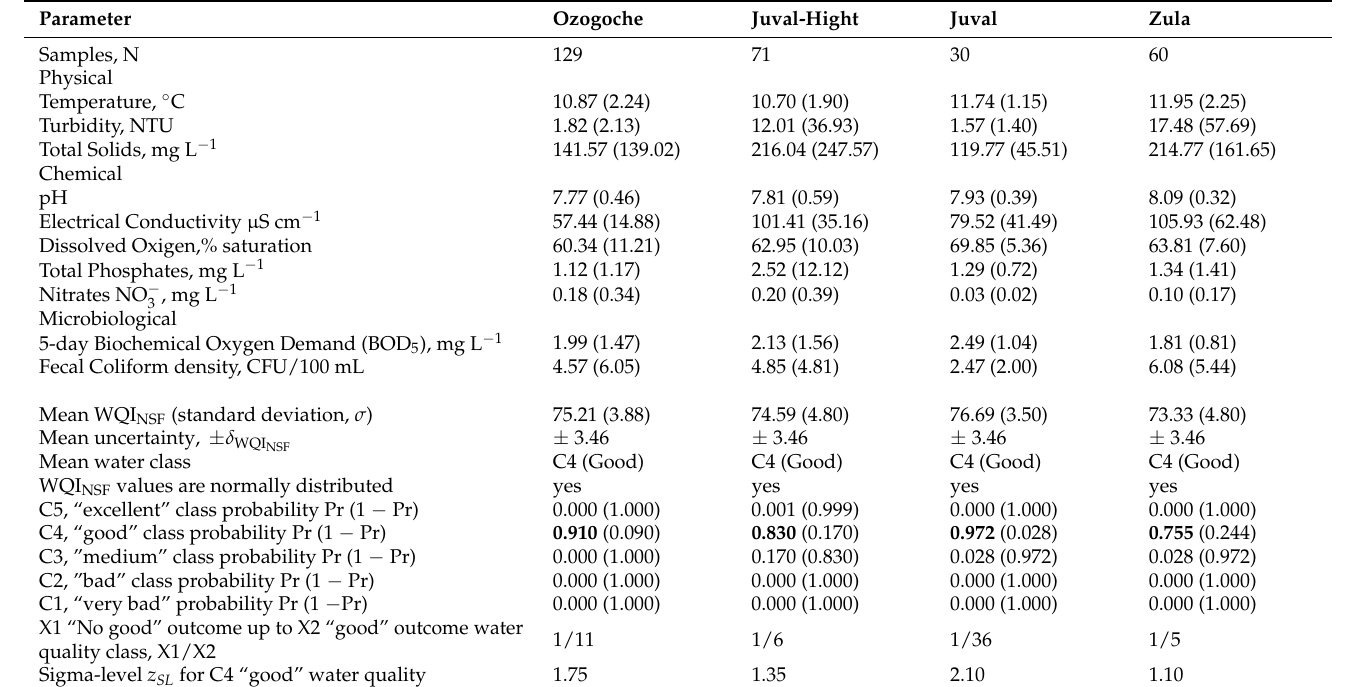
Table 7. Mean and standard deviation of physical, chemical, and microbiological